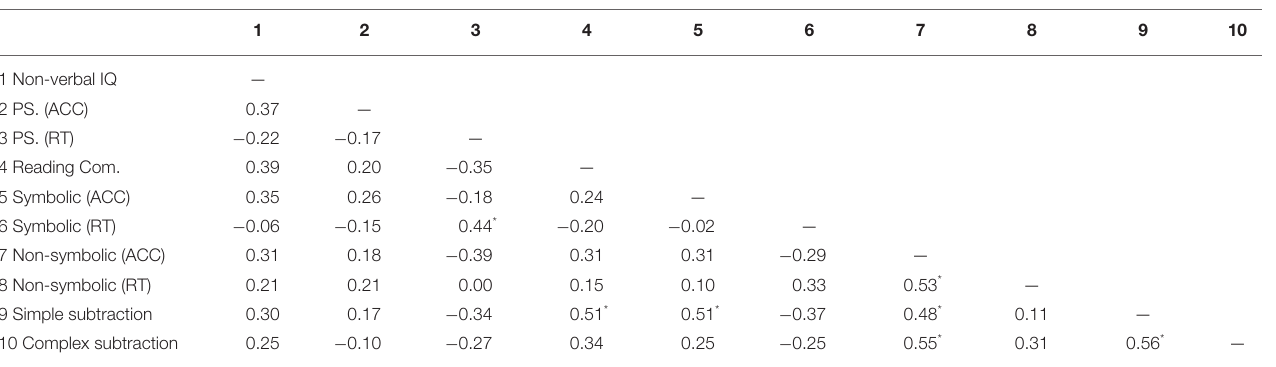
TABLE 3 | Partial correlations after controlling for age and gender differences among all the test scores in acquired